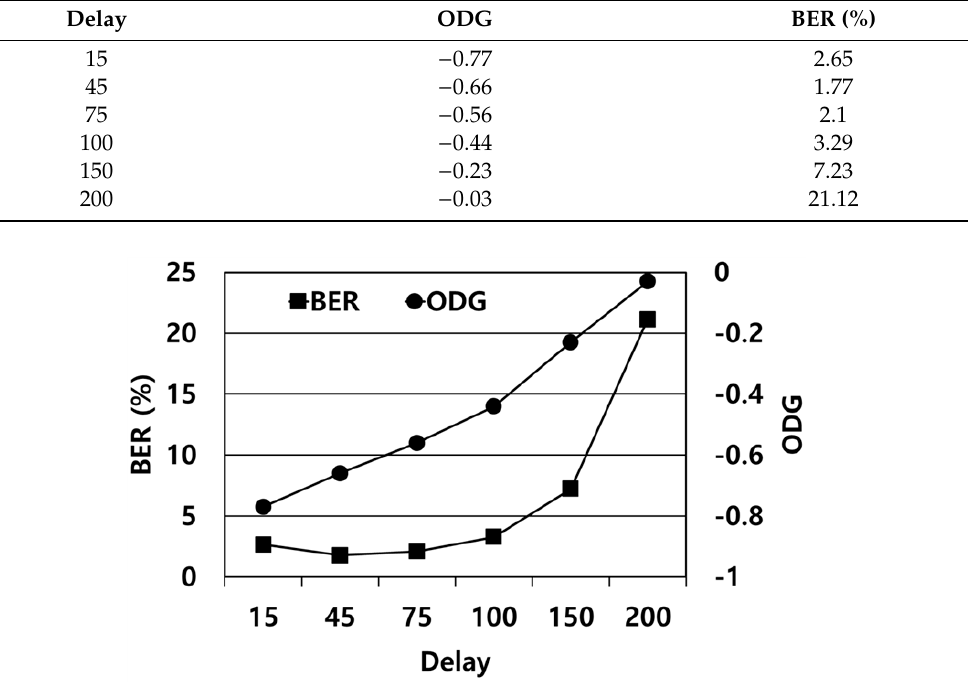
Figure 11. ODG and BER values under various delays. Table 5. ODG and BER values under various attenuation lengths of the window.